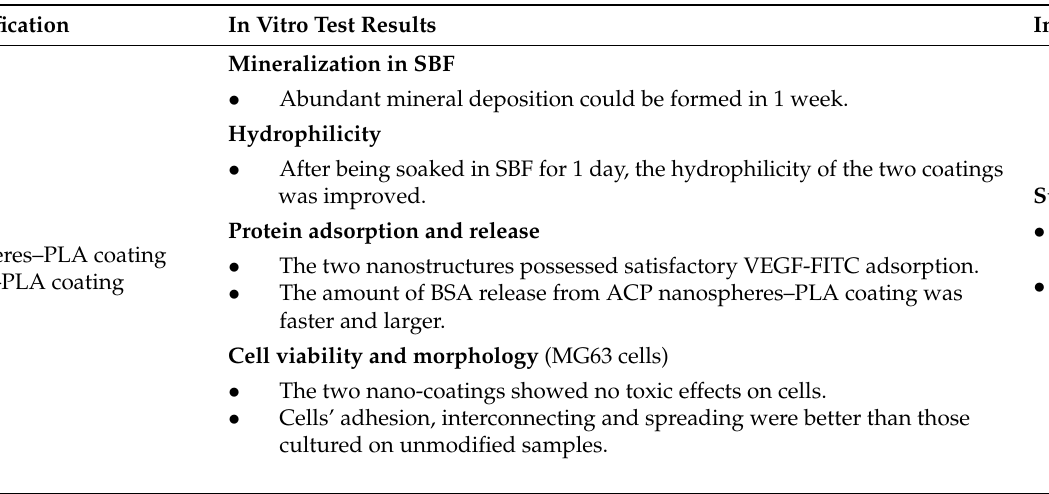
Table 3. The biological performance of different methods for Ta